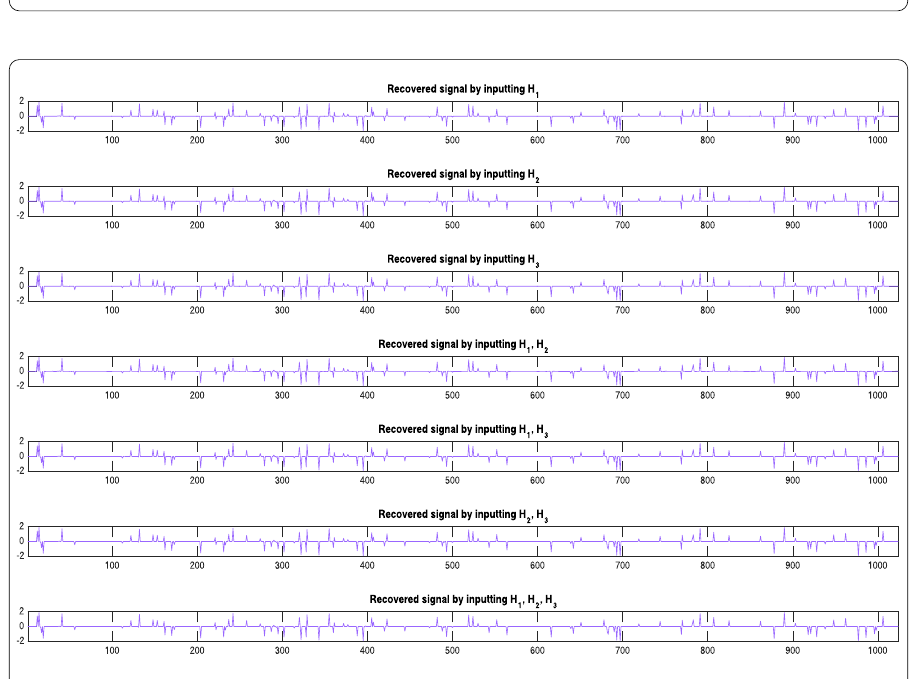
Figure 4 From top to bottom: the reconstructed signals by using each input for m =